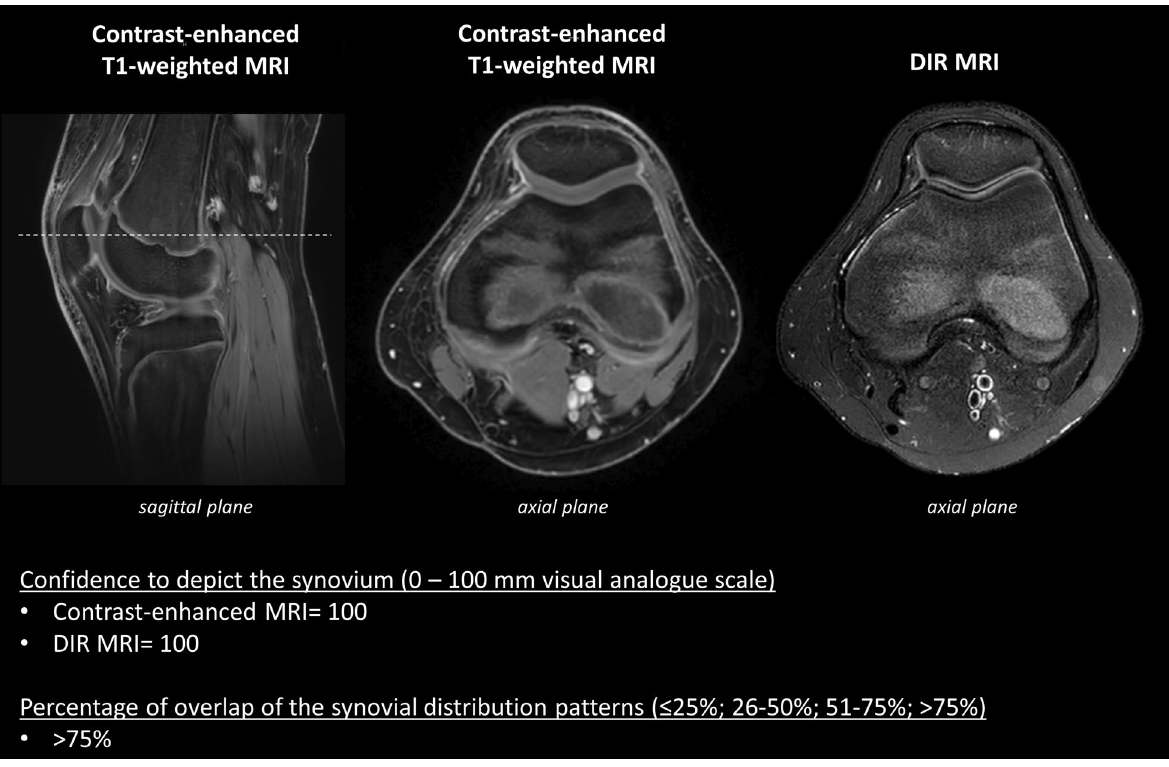
Fig. 2 Images obtained in a 14‑year‑old boy, diagnosed with extended oligoarticular JIA, without knee arthritis. Confidence to depict the synovium was 100 (0–100 mm visual analogue scale) for the axial contrast‑enhanced MRI and the axial DIR MRI. The percentage of overlap of synovial distribution patterns was scored as >